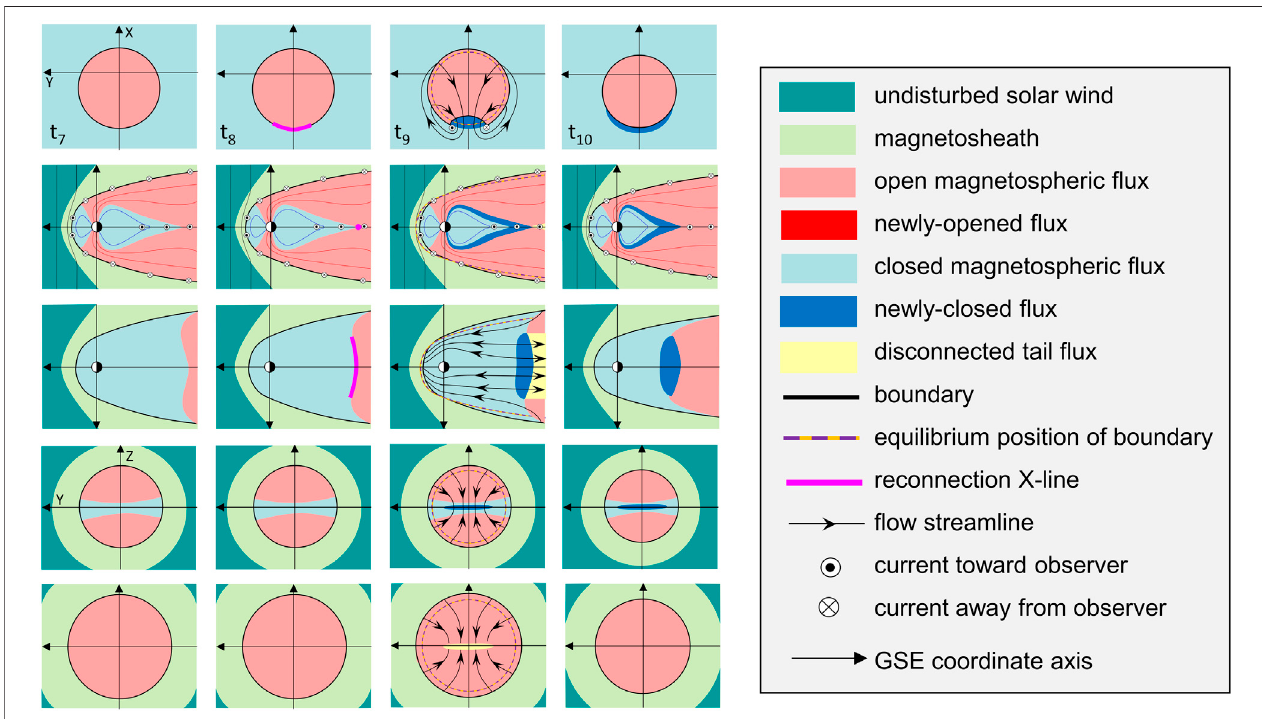
FIGURE 8 | Same a Figure 7 but showing the response (at times t 7 - t 10 ) to the closure of open fl ux by a burst of reconnection in the cross-tail current sheet. The newly-closed fl ux is shown in dark blue.